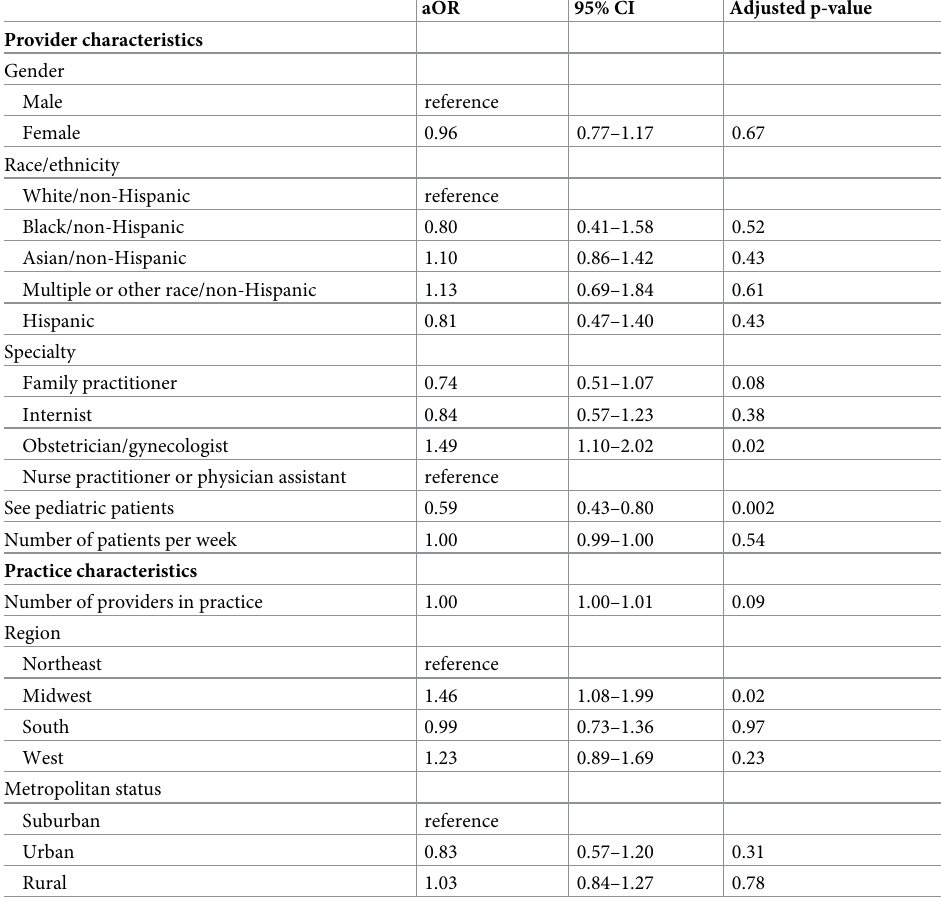
Table 2. Multivariable analysis of factors associated with “always” or “usually” ordering diagnostic testing for vul- vovaginal candidiasis (VVC)–Porter Novelli Spring DocStyles Survey, United States,